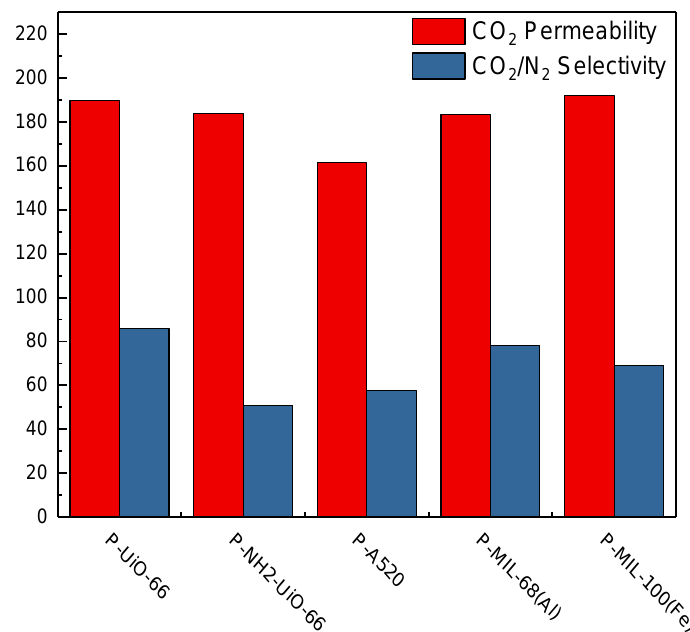
Figure 7. Gas separation efficiency diagram of PEBAX/5wt% MOF.